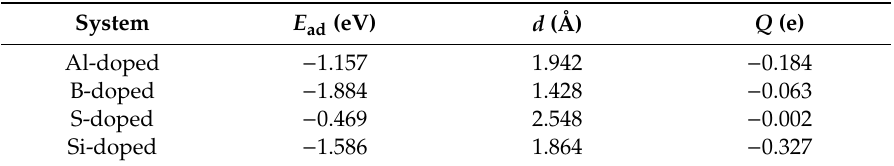
Figure 3. Top view and side view of the most energetically favorable adsorption configurations for NO adsorbed on ( a ) Al-, ( b ) B-, ( c ) S- and ( d ) Si-doped monolayer arsenene. The O and N atoms are labeled red and blue, respectively. Table 2. Adsorption energy ( E ad ), the shortest distance of the As-dopant atom ( d ) and Mulliken charge ( Q ) for the optimized stable configurations of gas molecules on Al-, B-, S- and Si-doped arsenene. A negative Q value indicates electron move from the doped substrates to NO molecule.